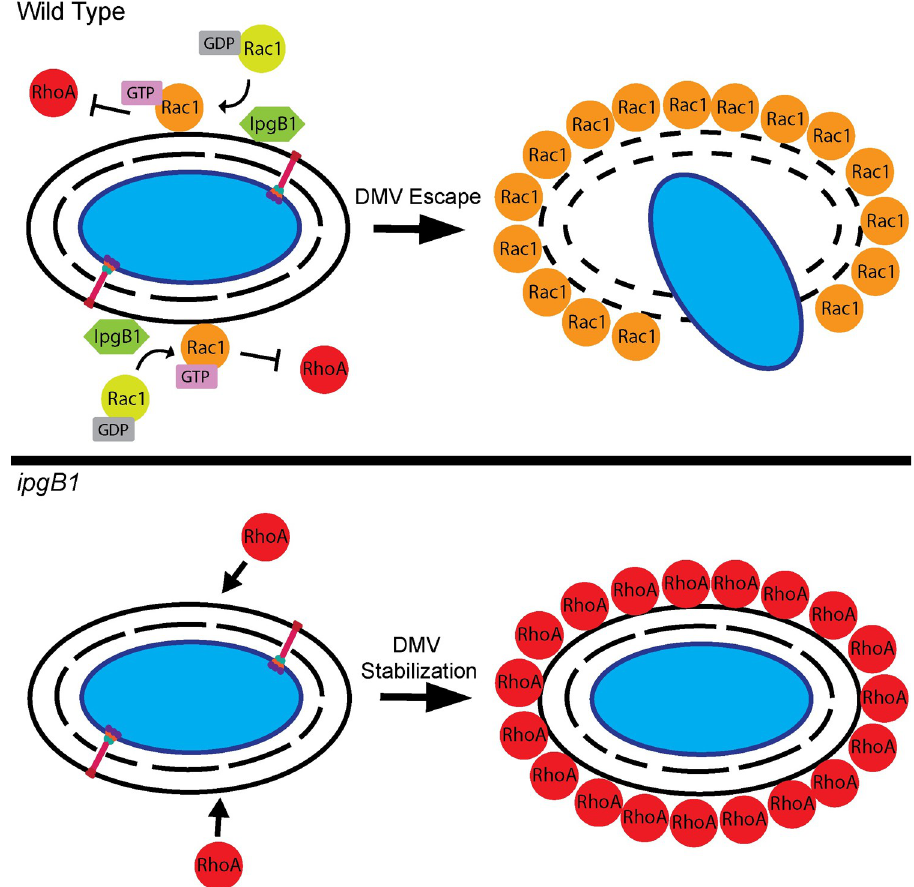
Fig 9. Model for the role of IpgB1 in DMV escape during S . flexneri cell-to-cell spread. In wild type S . flexneri , the type three secretion bacterial GEF, IpgB1, recruits Rac1 to DMVs. The IpgB1-Rac1 pathway antagonizes RhoA recruitment to the DMVs to promote DMV escape. The ipgB1 mutant has diminished ability to recruit Rac1 to the DMV, which allows for the accumulation of RhoA and initiation of RhoA-mediated DMV stabilization, which impedes DMV